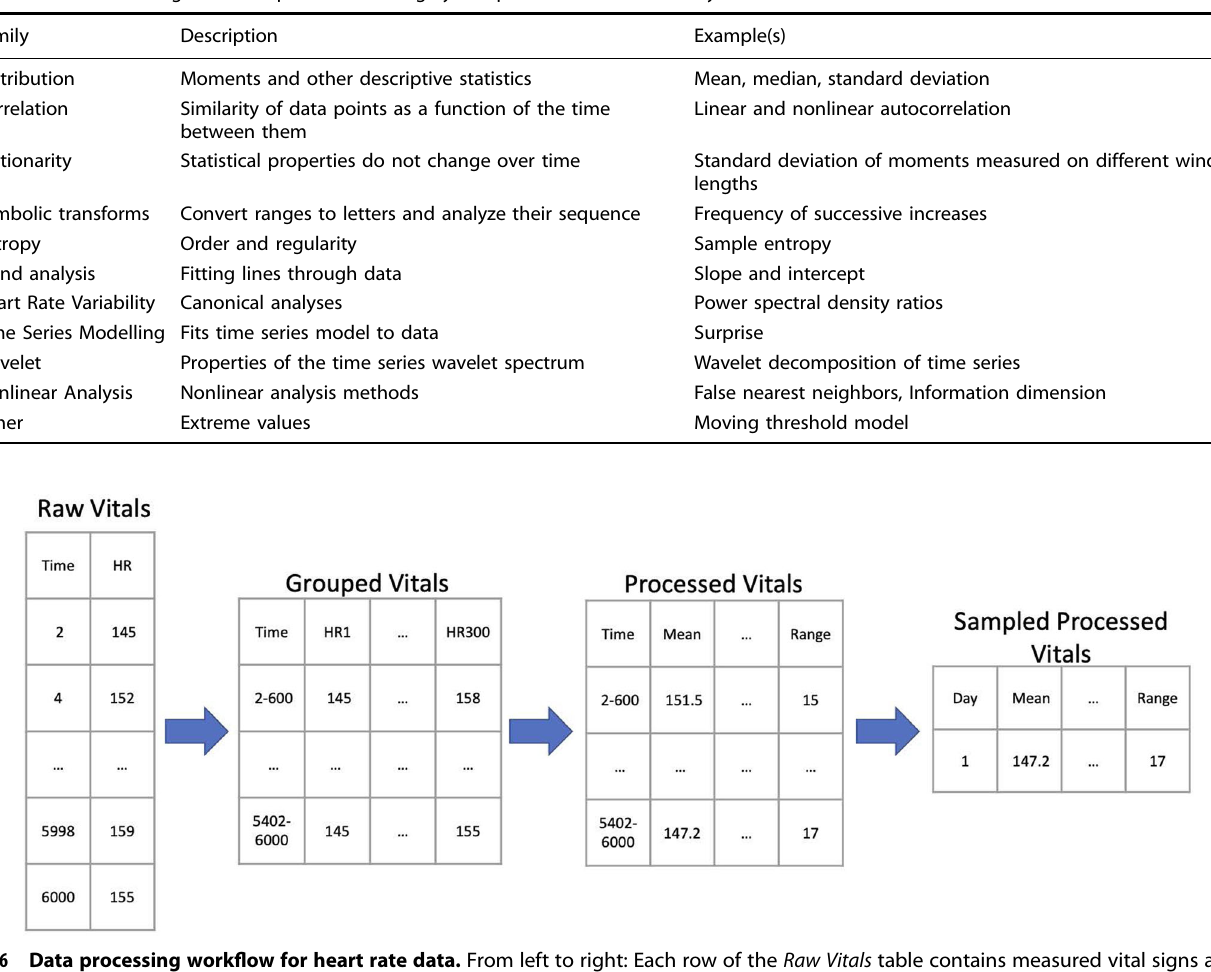
Table 4. Families of algorithms implemented in highly comparative time series analysis.